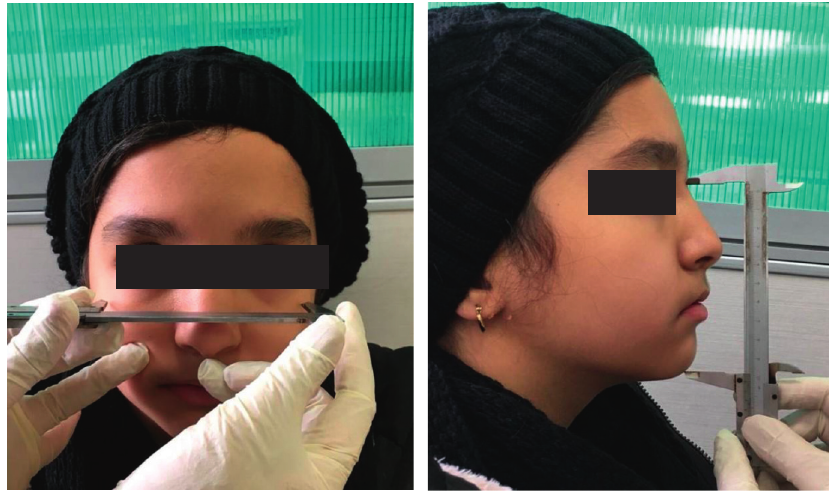
Figure 1: Measuring the facial width and height using a caliper.